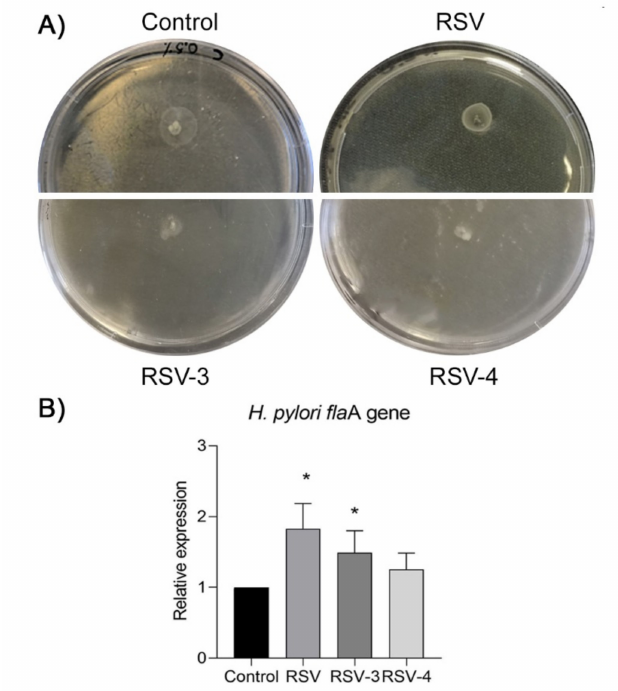
Figure 4. E ff ect of RSV, RSV-3, and RSV-4 at 1 / 4 MIC concentrations on the H. pylori motility and on the expression of fla A gene. ( A ) Representative images of H. pylori 13A / 13 motility on soft agar 0.5%. RSV-3 and RSV-4 induced a significant loss of motility with respect to RSV and the untreated sample (control), as shown by a smaller diameter of growth on soft agar plates. ( B ) Relative gene expression of H. pylori fla A gene in the presence of RSV, RSV-3, and RSV-4. * Statistically significant values with respect to the